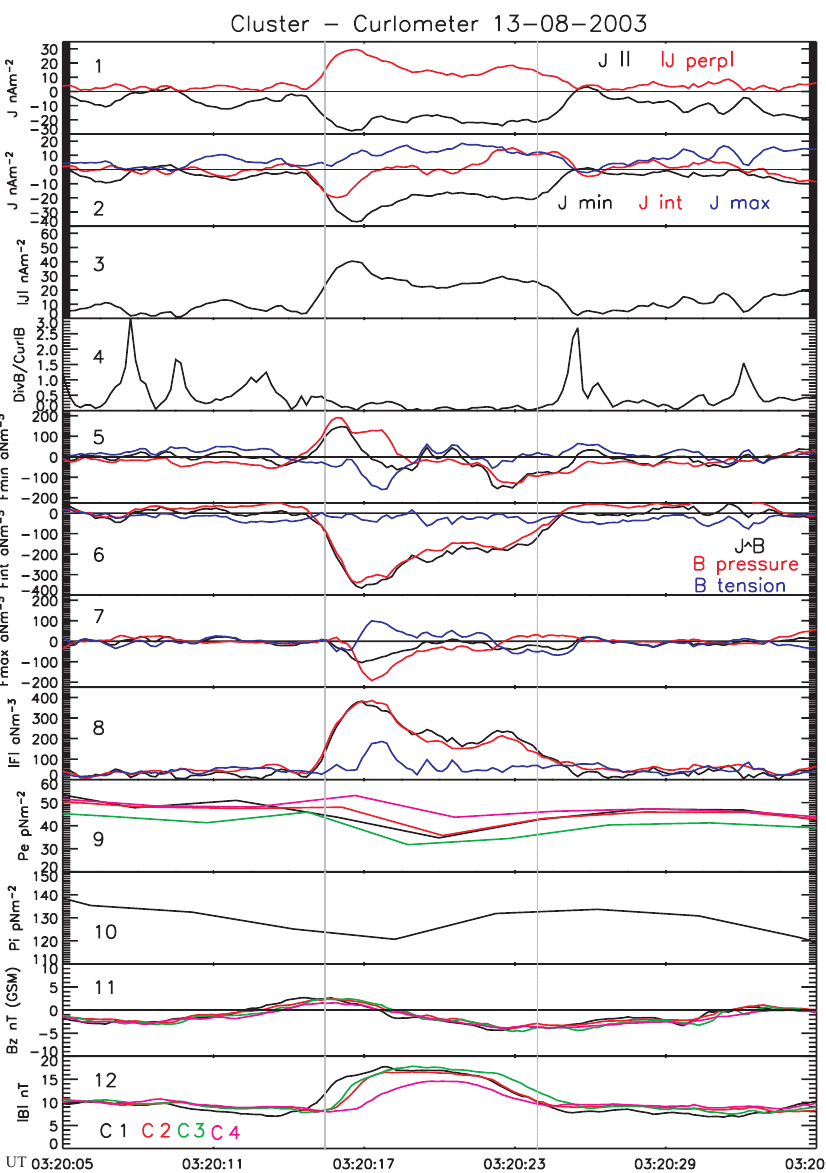
Fig. 5. Cluster observations of a small-scale, tailward-moving flux rope on 13 August 2003. Panel 1 shows the current parallel (black) and the magnitude of the current perpendicular (red) to the magnetic field. Panel 2 shows the current projected into the minimum (black), intermediate (red) and maximum (blue) variance directions, respectively. Panels 3 and 4 show the magnitude of the current and the fractional error in the curlometer result, respectively. Panels 5 to 7 show J × B (black), the magnetic pressure (red) and the magnetic tension (blue) projected onto the minimum, intermediate and maximum variance directions of Cluster 1, respectively. Panel 8 shows | J × B | and the magnitudes of the magnetic pressure and tension forces. Panels 9 and 10 show the electron and ion pressure, respectively, with the final two panels showing the B z and | B | observations illustrating the bipolar signature and increase in | B | , respectively. The observations illustrate significant magnetic forces within the flux rope, especially towards the edges, and support the premise that the structure has yet to evolve into the force-free state associated with flux ropes in the more distant tail (from Henderson et al.,